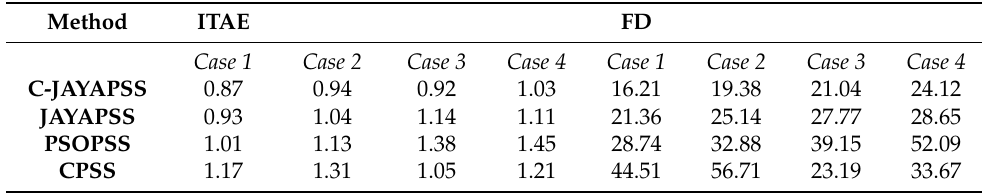
Table 3. Performance indices’